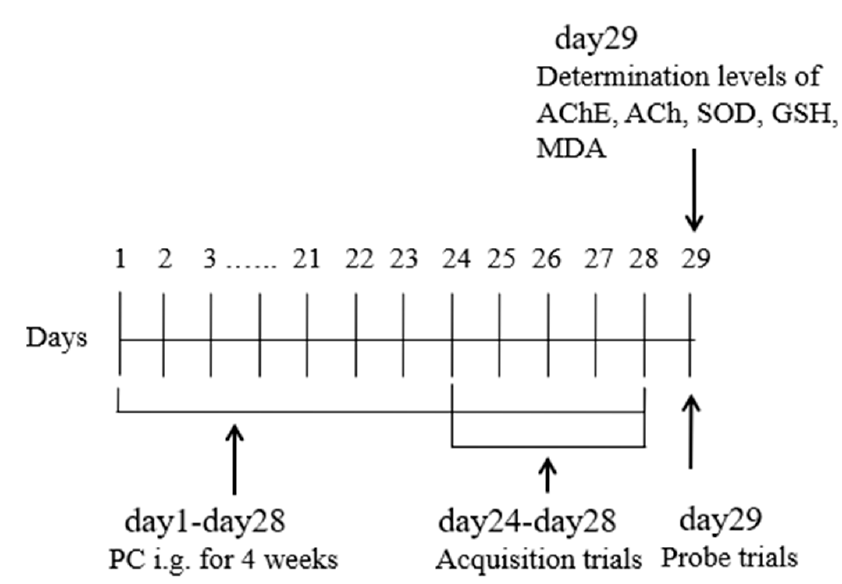
Figure 1. Schematic of the MWM testing and PC administration.